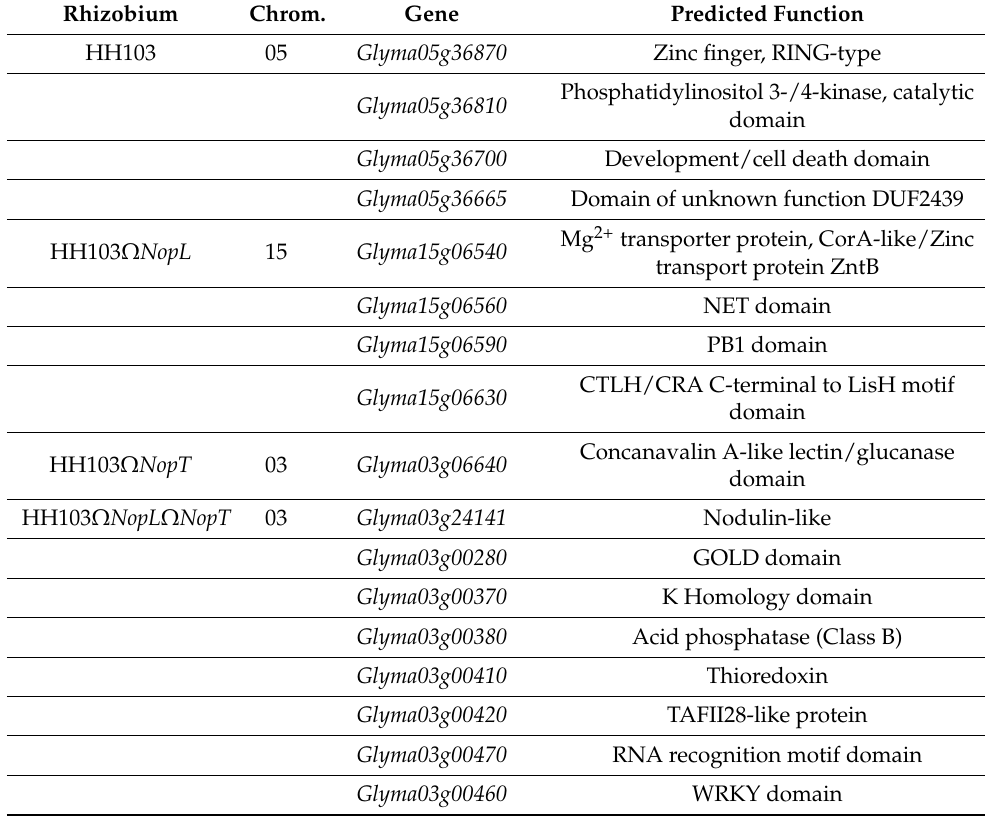
Table 3. Annotation of candidate